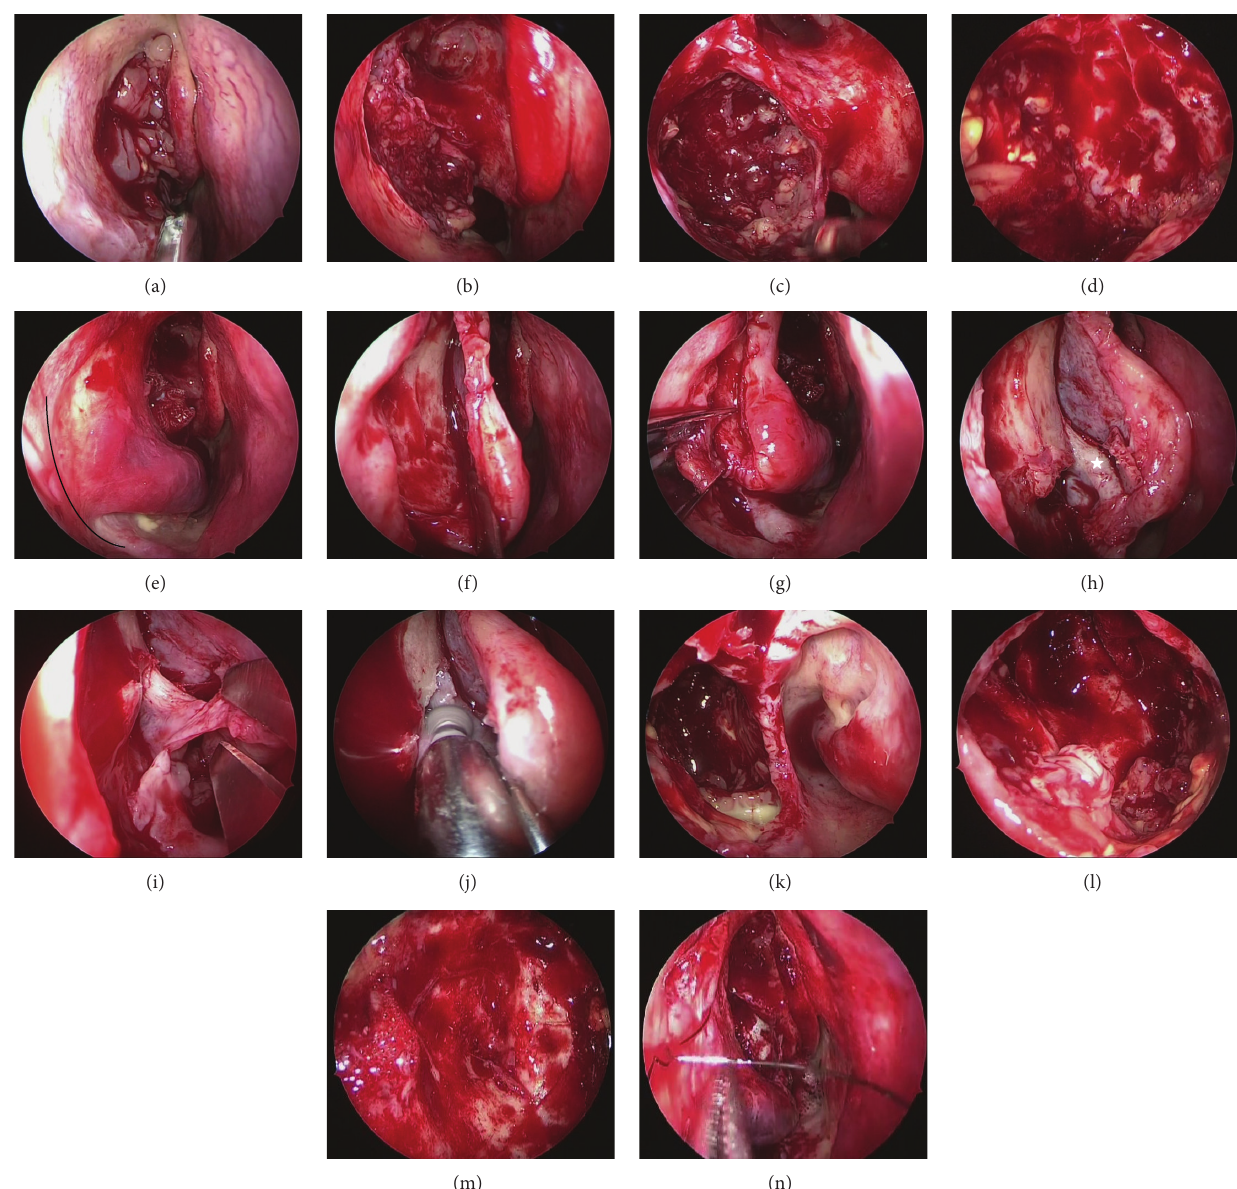
Figure 3: Endoscopic Modified Medal Maxillectomy (EMMM). (a) The uncinate process was resected, and an IP deviating from the maxillary sinus was observed. (b) The uncinate process and ethmoidal bulla were resected, and the maxillary sinus was opened. A tumor was found to be filling the maxillary sinus. (c) Inverted papilloma in the maxillary sinus was debulked. All of the IPs were adhering to the posterior wall. (d) The anterior and inferior walls of the maxillary sinus were not visible when viewed from the fontanelle of the maxillary sinus with a 70-degree endoscope. (e) From the anterior portion of the inferior turbinate behind the pyriform aperture, the mucosa was incised towards the floor of nasal cavity (black line). (f) The mucosa of inferior turbinate was detached. The mucosa on the inferior meatus was detached to expose the conchal crest. (g) The conchal crest was cut with a chisel, the inferior turbinate bone was disengaged, and the inferior turbinate was moved medially. (h) When the inferior turbinate was moved medially, the conchal crest and the inferior end of the nasolacrimal duct (*) could be observed. (i) The nasolacrimal duct was identified, and the IP that was deviating to the inferior meatus was resected. (j) The lacrimal process of the inferior turbinate, frontal process of the maxilla, and inferior portion of the lacrimal bone were drilled with 2.5 mm Curved Diamond DCR Bur (Medtronic), in order to make the superior portion of the lacrimal duct visible. (k) The inside of the maxillary sinus was visible from the inferior meatus side. (l) Inverted papilloma was observed on the anterior and inferior walls. (m) All of the IPs found on the anterior and inferior walls were resected with the 70-degree endoscope. (n) The pyriform aperture and mucosa of the inferior turbinate were sutured and the surgery was